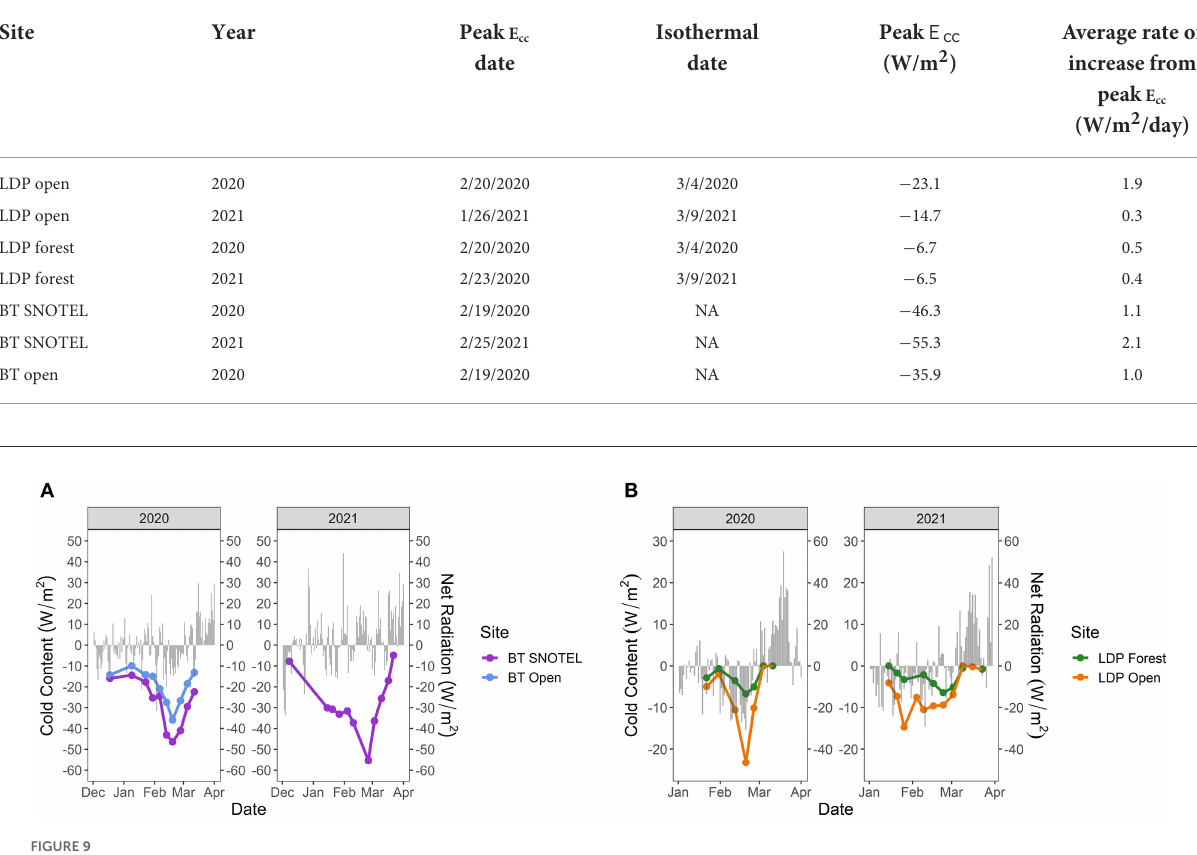
FIGURE9 Snowpack cold content at the BT pit sites (A) and LDP pit sites (B) with net total radiation at each